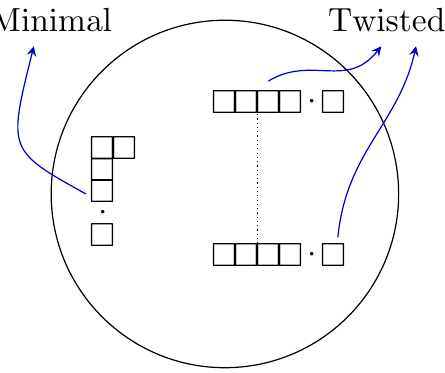
Figure 15. Class S description of the R 2 ,k